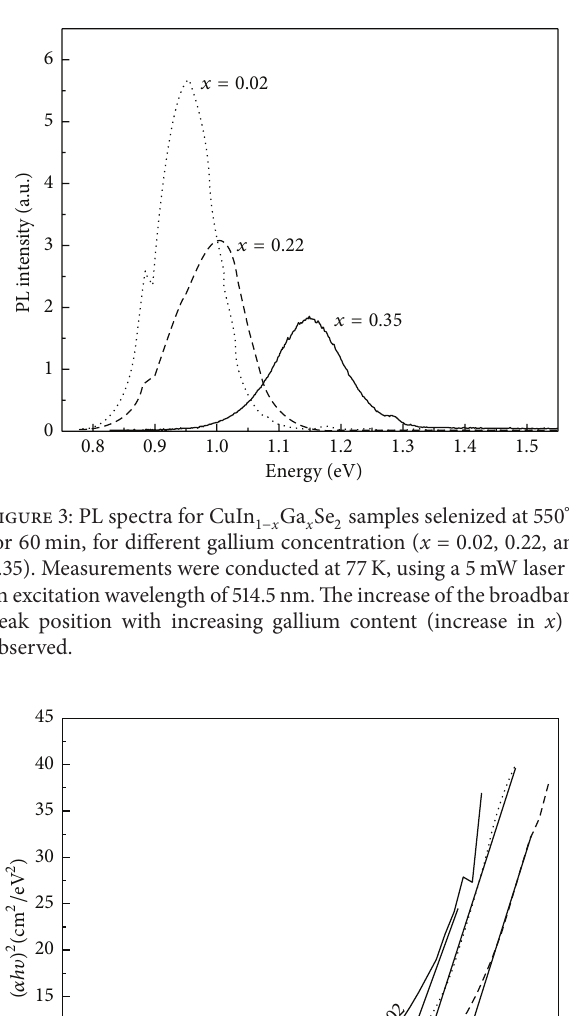
Figure 4: Graph of ( 𝛼ℎ𝜐 ) 2 versus ℎ𝜐 for different concentrations of gallium in CuIn 1−